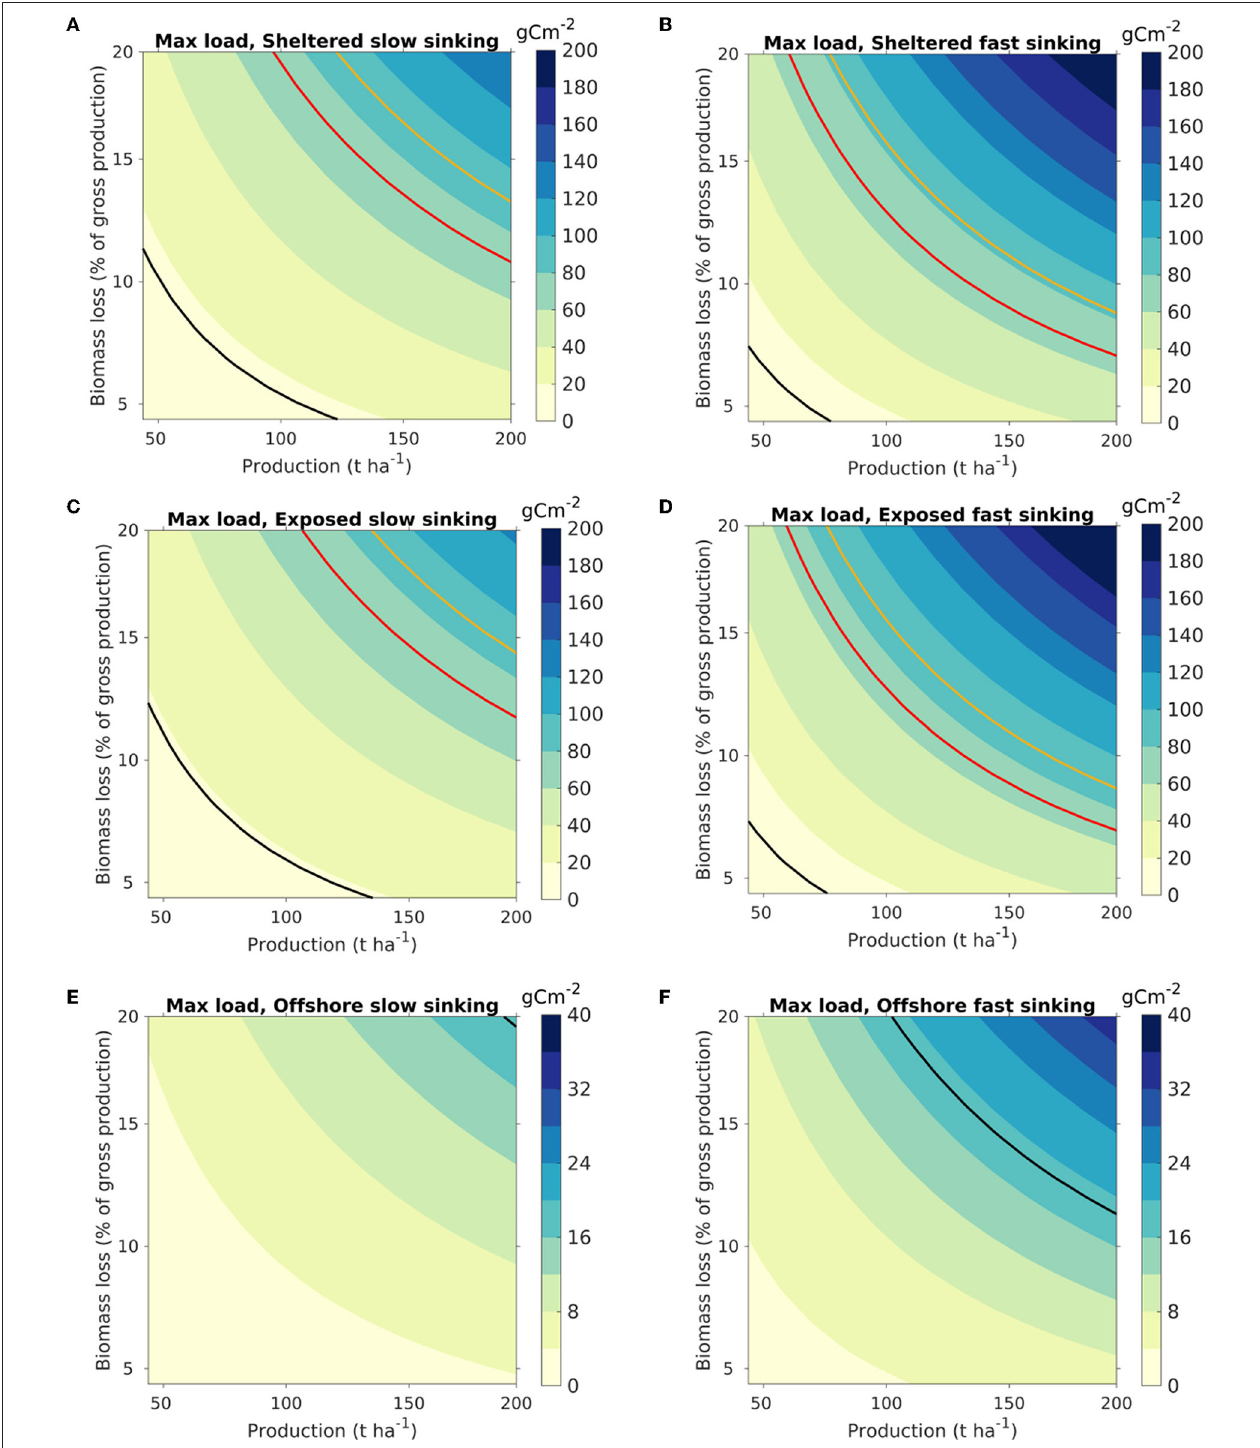
FIGURE 6 | Maximum organic loading on the seafloor from kelp cultivation, visualized as a function of the production density (t WW harvested biomass ha − 1 ) of S. latissima (abscissa) and the biomass loss (ordinate) (Equation 8). The colors indicate the highest loading within the model domain, with release from each of the three locations [sheltered: (A,B) ; exposed: (C,D) ; offshore: (E,F) ]. The color scaling varies between the release locations. Results are shown for scenarios A [slow sinking POM, (A,C,E) ] and B [fast sinking POM; (B,D,F) ]. The isocurve in red represents 72 g C m − 2 , corresponding to estimated net pelagic primary production in the Norwegian Sea (Skogen et al., 2007; Hansen and Samuelsen, 2009). The black and yellow isocurves represent loadings of 19 and 90 g C m − 2 , equivalent to the loading from an S. latissima production of 100 t WW ha − 1 with, respectively, 5 and 20% loss calculated from (Equation 7), assuming direct deposition without horizontal advection of the POM (cf. Equation